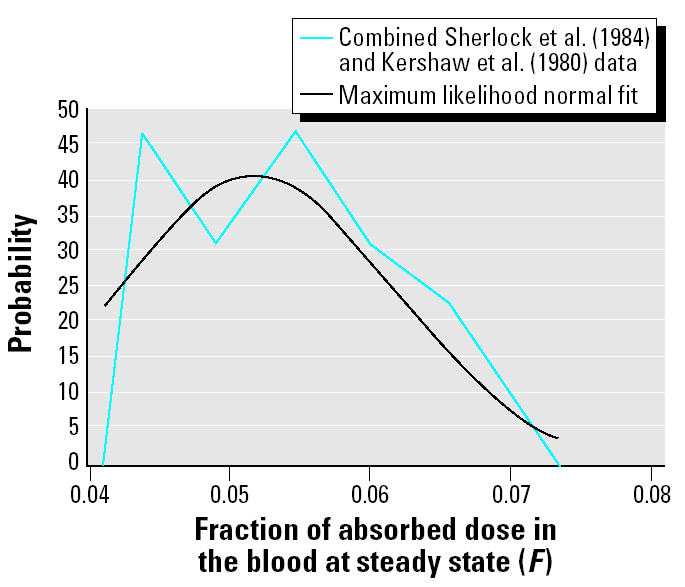
Comparison of combined Sherlock et al. (1984) and Kershaw et al. (1980) data on fraction of the dose in maternal blood to the maximum likelihood normal distribution.